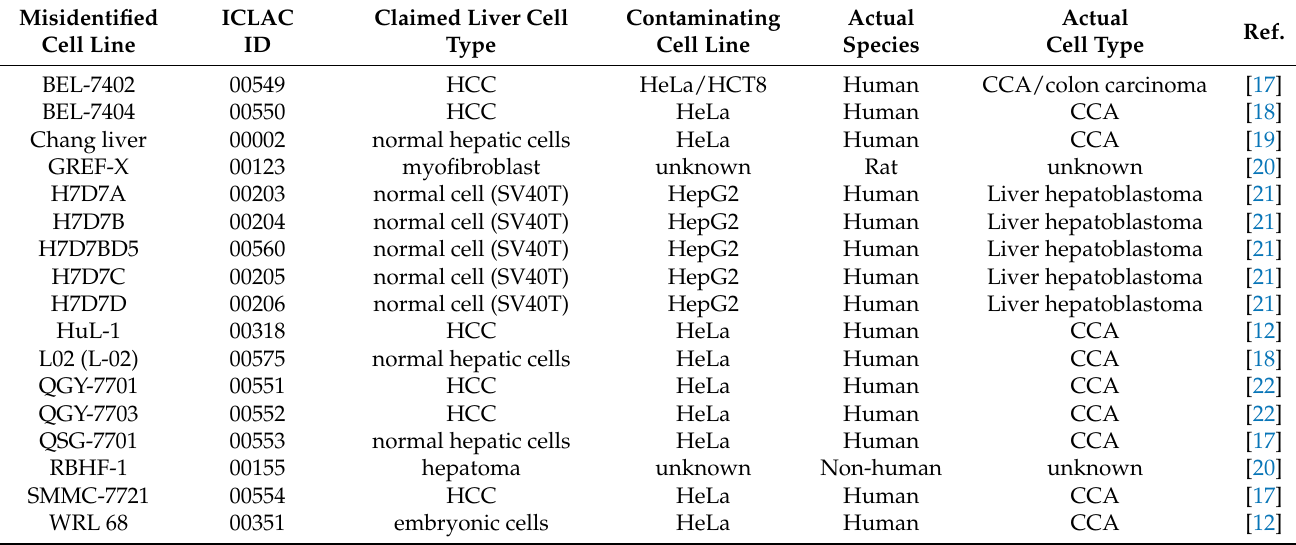
Table 1. Selection of misidentified human liver cell lines